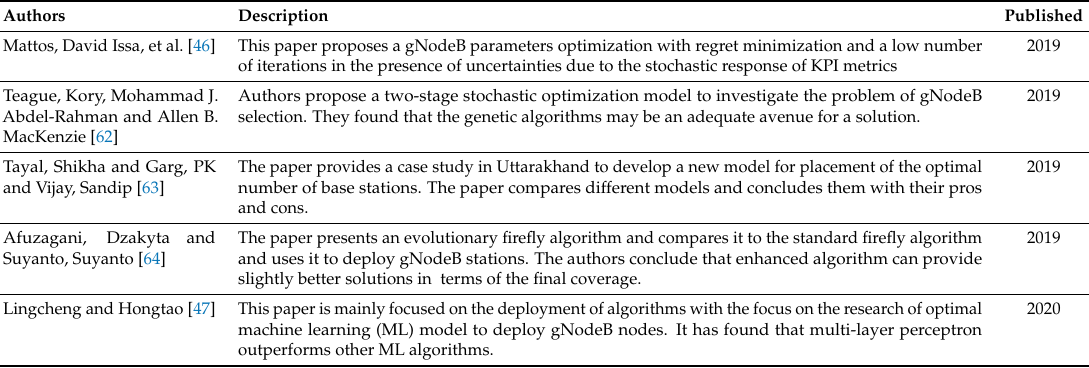
Table 3. An overview of recent papers targeting the deployment of gNodeB